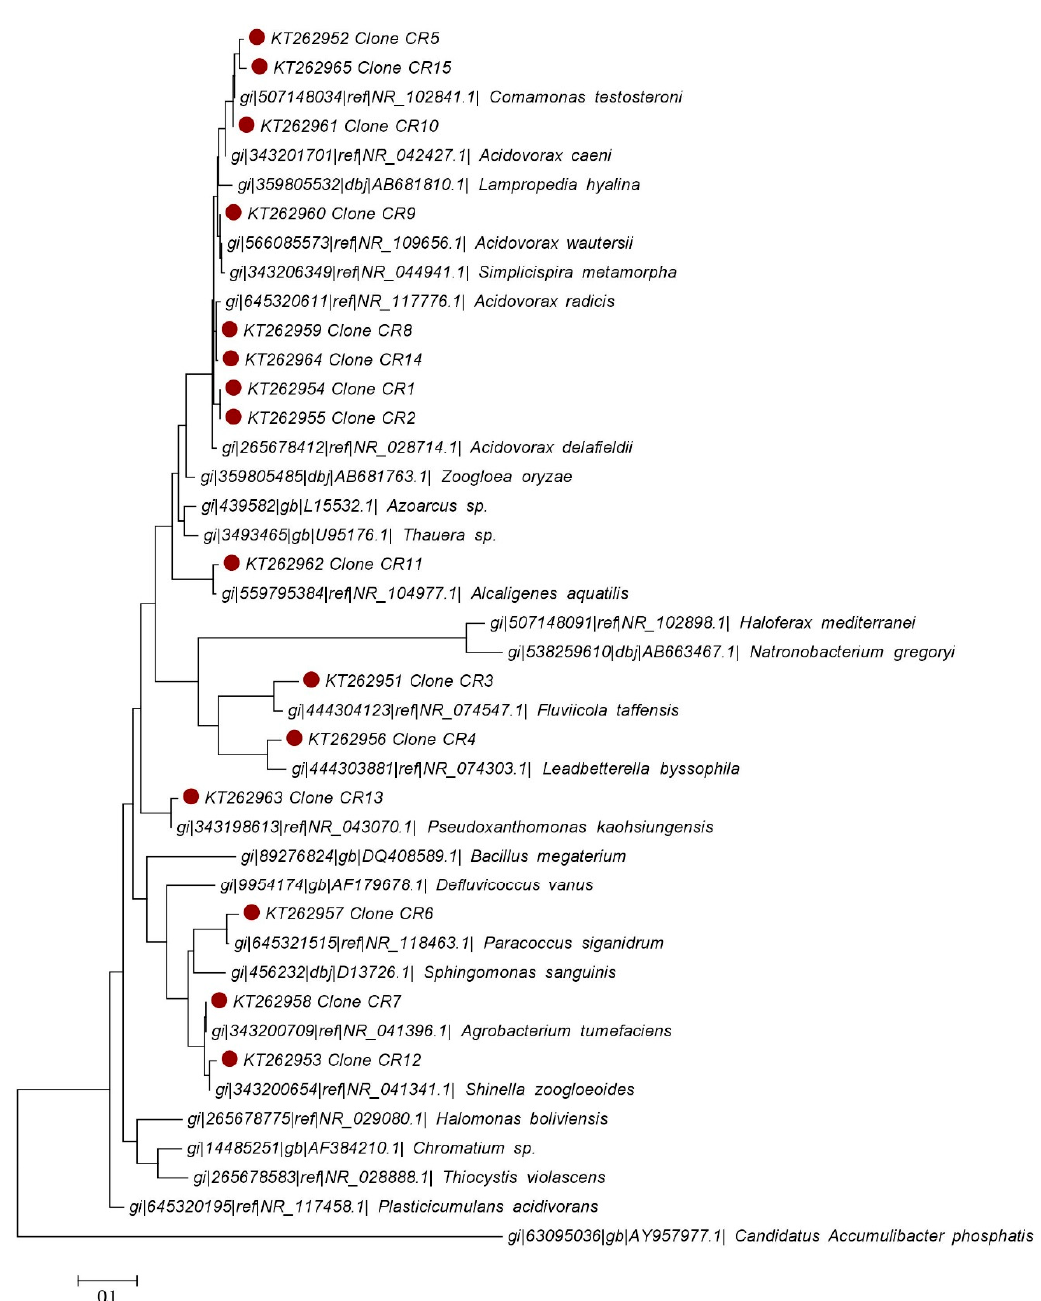
Figure 6. Phylogenetic tree based on full-length nucleotide sequences of 16S rRNA gene of clones CR1-15 (in the tree preceded by a filled red dot). Molecular phylogenetic analysis by maximum Likelihood method. The tree is drawn to scale, with branch lengths measured in the number of substitutions per site. The analysis involved 42 nucleotide sequences. Evolutionary analyses were conducted in MEGA6.